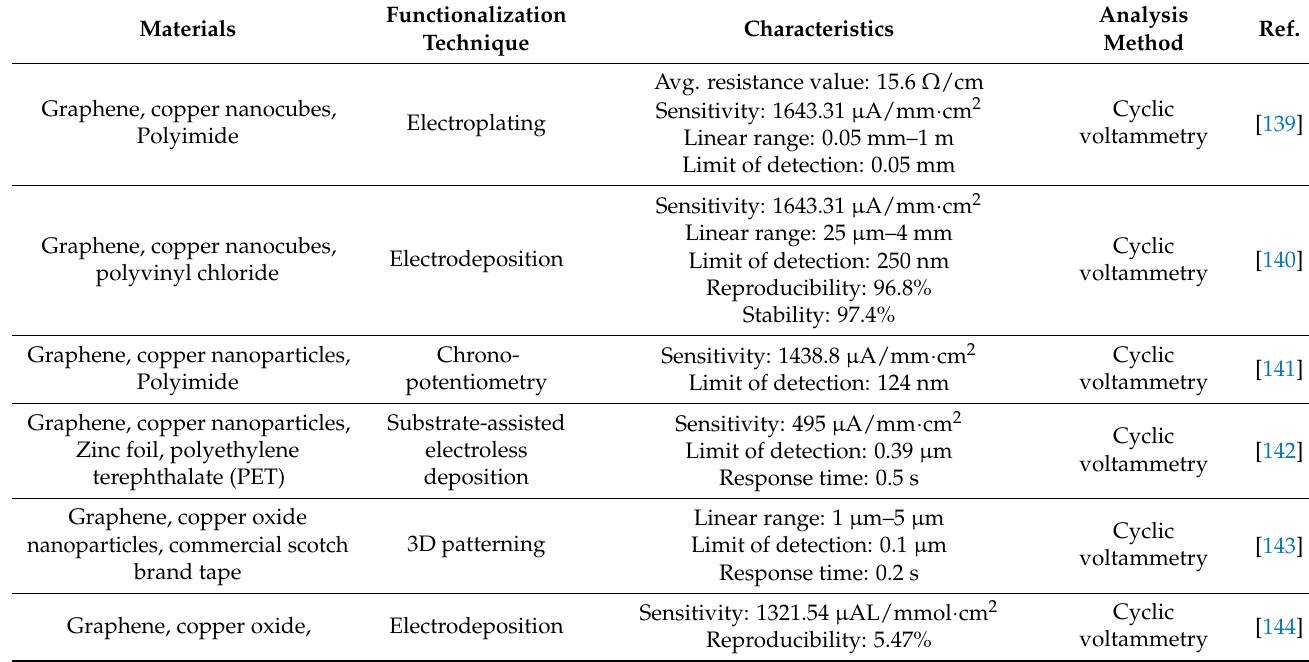
Analysis Method